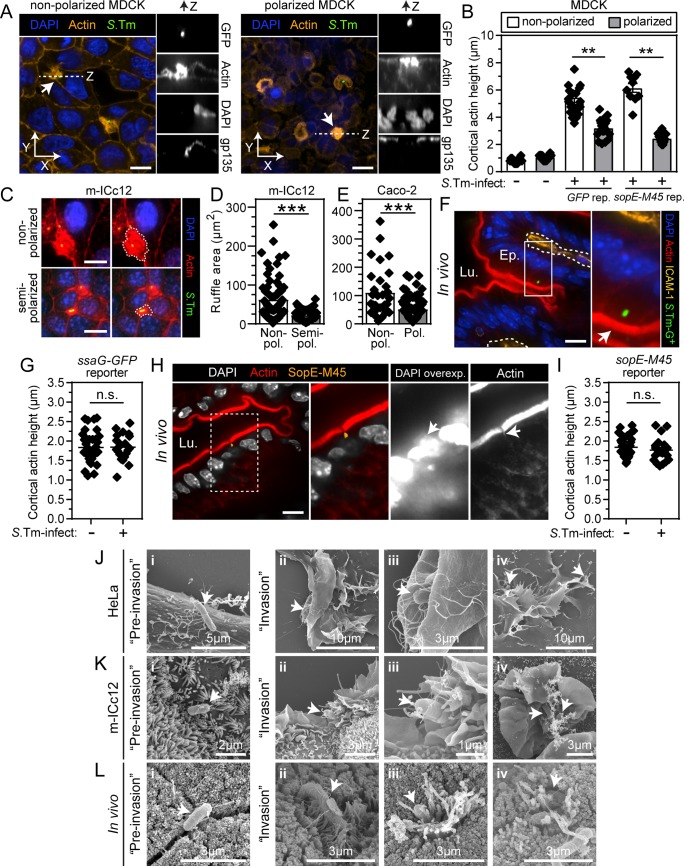
S.Tm-induced entry structures differ between epithelial cell lines and the absorptive gut epithelium in mice.(A-E) Epithelial cell polarization status affects the size of S.Tm-induced actin ruffles. (A) Confocal microscopy Z-stack visualizations of non-polarized and polarized MDCK cells infected with S.Tmwt/pGFP. Scale bar: 10μm. (B) Quantification of cortical actin height at invasion foci in MDCK cells infected with S.Tmwt/pGFP or S.Tmwt/psopE-M45. (C) Representative maximum intensity projection micrographs of non-polarized and semi-polarized m-ICc12 cells grown atop Transwell inserts and infected with S.Tmwt/pmCherry (green pseudocoloring). White dashed line indicate S.Tm-induced entry structures. Scale bars: 10μm. (D-E) Quantification of S.Tm-induced ruffle area in (D) non-polarized and semi-polarized m-ICc12 cells and (E) non-polarized and polarized Caco-2 C2Bbe1 cells grown atop Transwell inserts. (F-I) Intact actin brush border without signs of actin ruffle formation in the S.Tm-infected gut absorptive epithelium in vivo. (F-G) Wild-type mice were orally infected with S.Tmwt /pssaG-GFP for 6h. (F) Representative micrographs of the cecal epithelium. Blow-ups show magnifications of boxed regions. Lu.—Lumen; Ep.—Epithelium. White arrows indicate the apical actin brush border of an infected cell. Scale bar: 10μm. (G) Quantification of actin brush border height in infected cells and uninfected neighbors. (H-I) Rag1-/- mice (used since detection of M45 relies on a mouse monoclonal) were orally infected with S.Tmwt/psopE-M45 for 8h. (H) Representative micrographs of a SopE-M45 positive focus in the cecal epithelium. Blow-up shows magnification of boxed region. Lu.—Lumen. White arrow indicates M45-positive bacterial focus. Scale bar: 10μm. (I) Quantification of actin brush border height in infected cells and uninfected neighbors. Each data point in B, D, E, G, and I corresponds to one (non-infected or infected) cell. Bar or line represents mean. Results are representative for two to three experiments in each case. Mann-Whitney U-test (n.s., not significant; **p<0.01; ***p<0.001). (J-L) Different ultrastructural appearance of S.Tm entry structures in epithelial cell lines and the gut absorptive epithelium in mice. (J-K) Representative SEM micrographs of (J) HeLa cells and (K) m-ICc12 cells infected with S.Tmwt for 6-10min at MOI 400. (L) Representative SEM micrographs of the cecal epithelium of mice infected with S.Tmwt. Arrows indicate S.Tm. Scale bars as indicated in each panel.